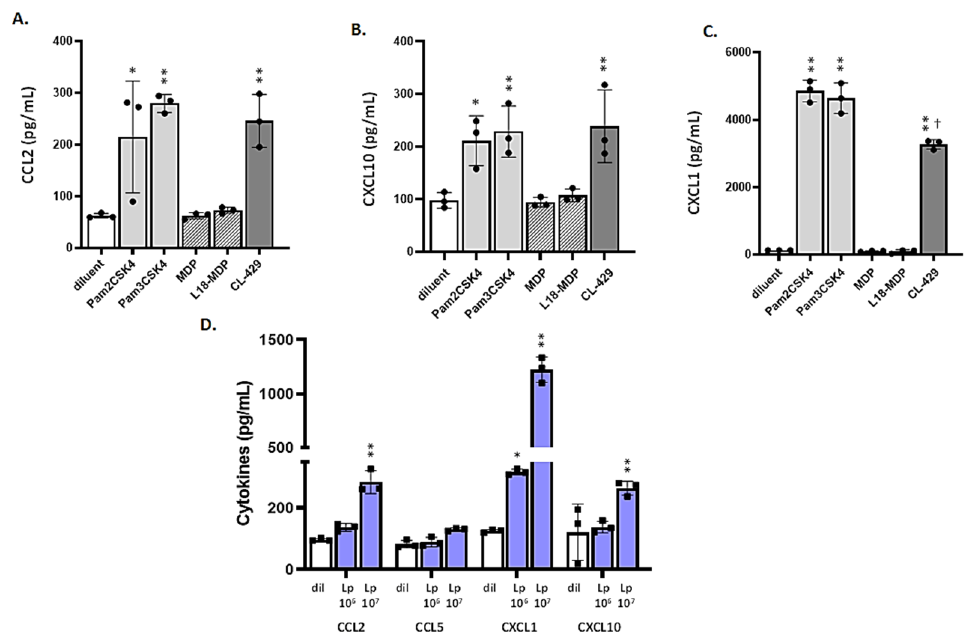
Figure 4. MLE-12 cells respond to Lp and TLR2 agonists. MLE-12 cells release pro-inflammatory mediators, including ( A ) CCL2, ( B ) CXCL10, and ( C ) CXCL1 at 24 h after a 2-h treatment with TLR2 ligands, Pam2CSK4 and Pam3CSK4, and the combined TLR2-NOD2 ligand CL-429 (Pam2C-MDP). No cytokine production was observed in response to the administration of the NOD2 ligands MDP or L18-MDP. All biochemical ligands were added to cultures at final concentrations of 10 ng/mL. ( D ) MLE-12 cells release pro-inflammatory mediators, including CCL2, CXCL1, and CXCL10, but not CCL5, at 24 h after a 2-h treatment with increasing concentrations of Lp (10 6 or 10 7 /mL); * p < 0.05 or ** p < 0.01 vs. diluent alone; † p < 0.05 vs. Pam2CSK4, one-way ANOVA.